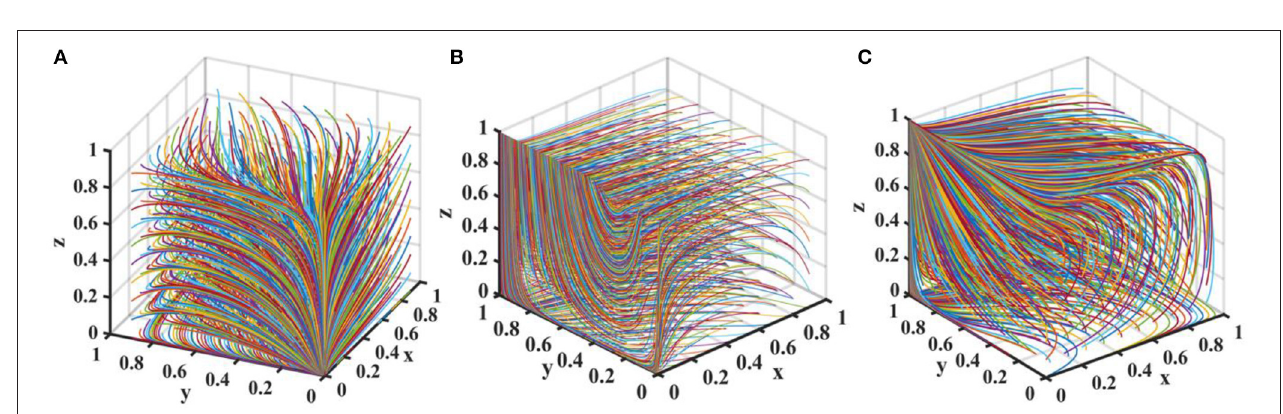
FIGURE 9 | Impact of penalties on the evolution of each player’s strategy. Figure is the simulation diagram that shows the influence of the penalties on the strategic choices of local government, drug enterprises, and third-party testing agencies. (A) When the situation F g = 0.0, F e = 0.0. (B) When the situation F g = 4.5, F e = 4.5. (C) When the situation F g = 6.0, F e =